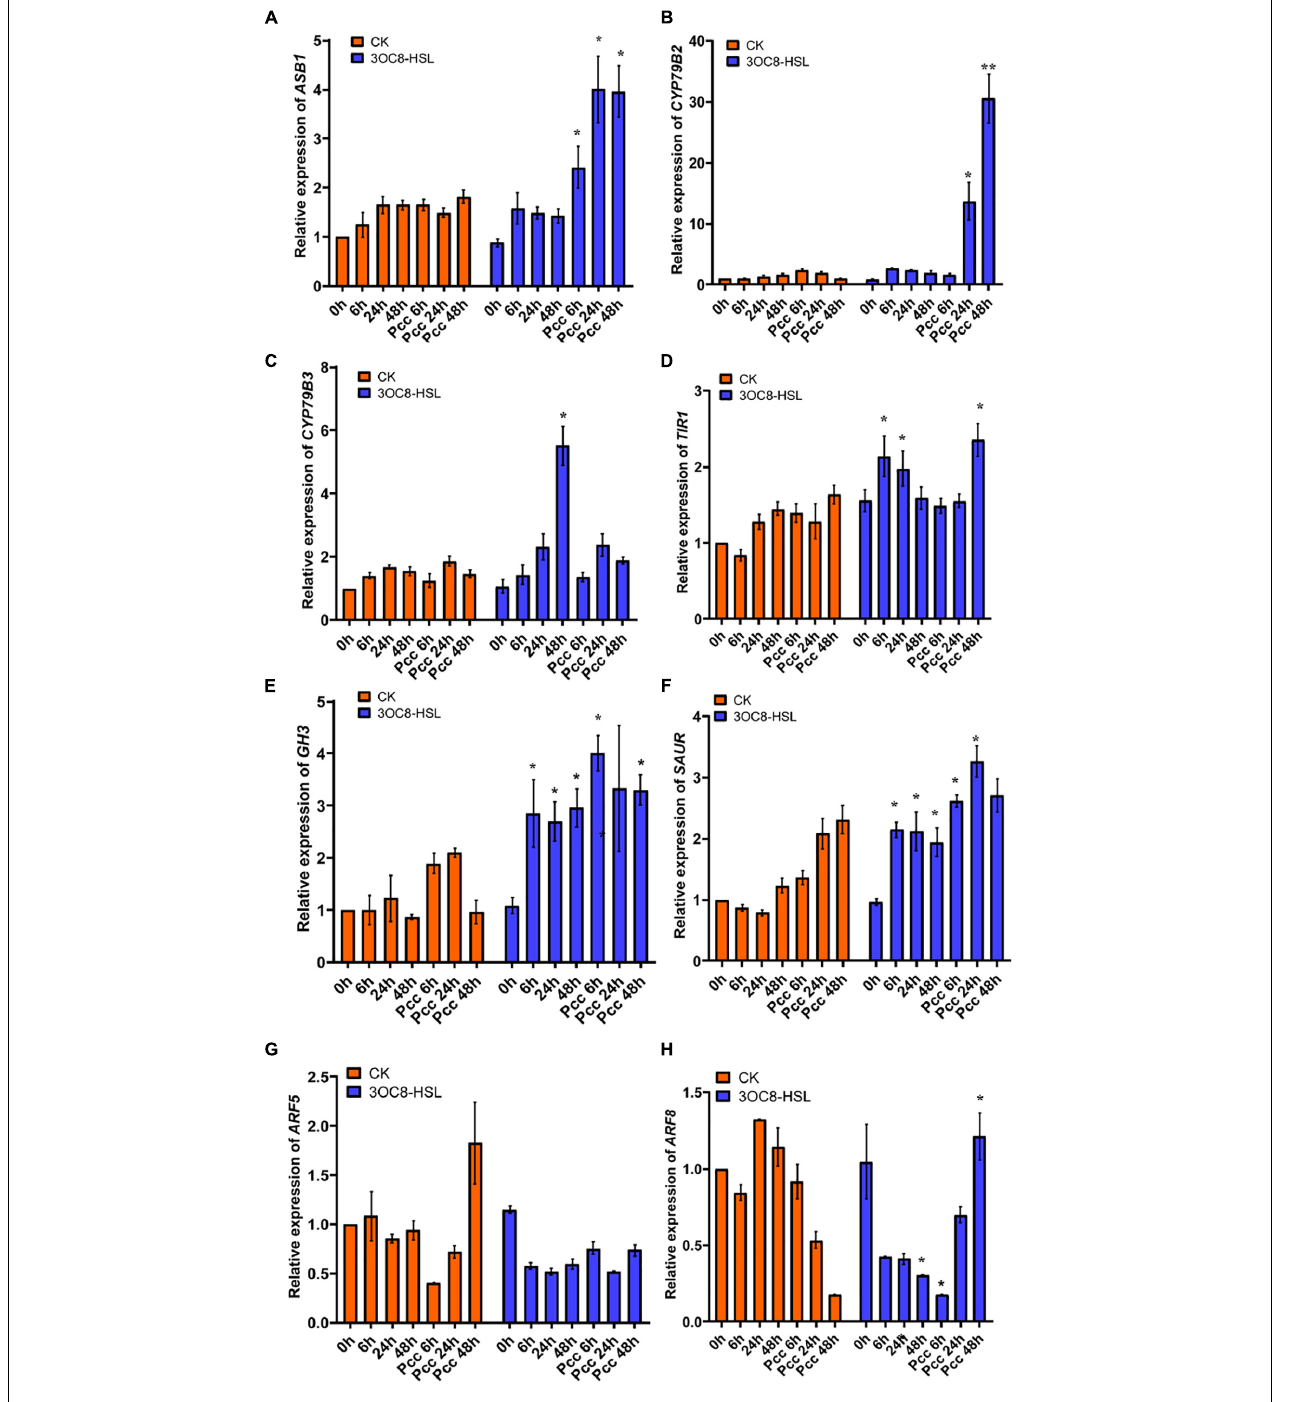
FIGURE 5 | Expressions of the auxin-related genes in Arabidopsis plants pretreated with 3OC8-HSL and challenged with Pcc . (A) Expression of Auxin pathway transcriptional regulators genes ASB1 . (B) Expression of auxin pathway transcriptional regulators gene CYP79B2. (C) Expression of auxin perception gene CYP79B3. (D) Expression of auxin synthesis gene TIR1. (E) Expression of auxin synthesis gene GH3. (F) Expression of auxin synthesis gene SAUR . (G) Expression of auxin downstream cascade gene ARF5 . (H) Expression of auxin downstream cascade gene ARF7 . At least five independent experiments were performed, each of which with three technical repeats. Asterisks indicate a statistically significant difference between the AHL-pretreated and the water-treated plants (ANOVA test, * P < 0.05). Values are means ± SD of five independent experiments.